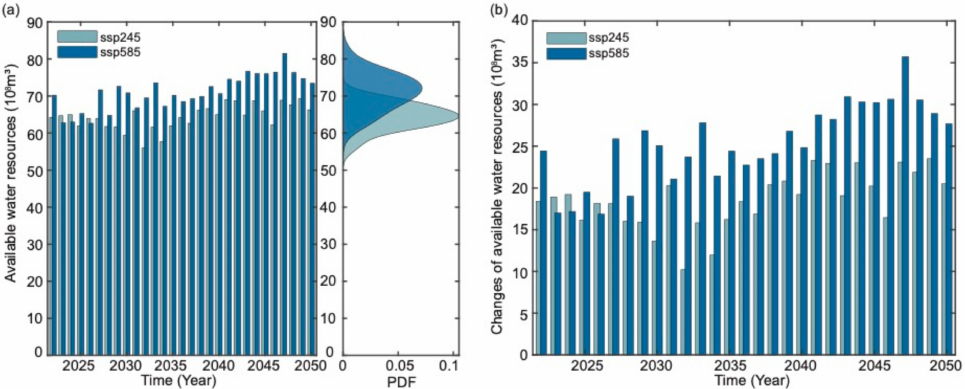
Figure 8. ( a ) Annual available water resources and their probability density functions (PDFs) in the Alar station of the upper Tarim River from 2022 to 2050 simulated by the NARX model under future climate scenarios SSP245 and SSP585. ( b ) Changes in annual available water resources in the Alar station of the upper Tarim River Basin compared with the values in the reference period from 1957 to 2017 under future climate scenarios SSP245 and